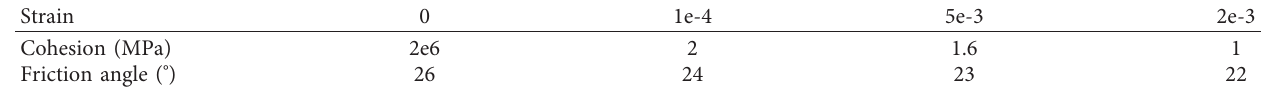
Table 5: Strain-softening parameters of